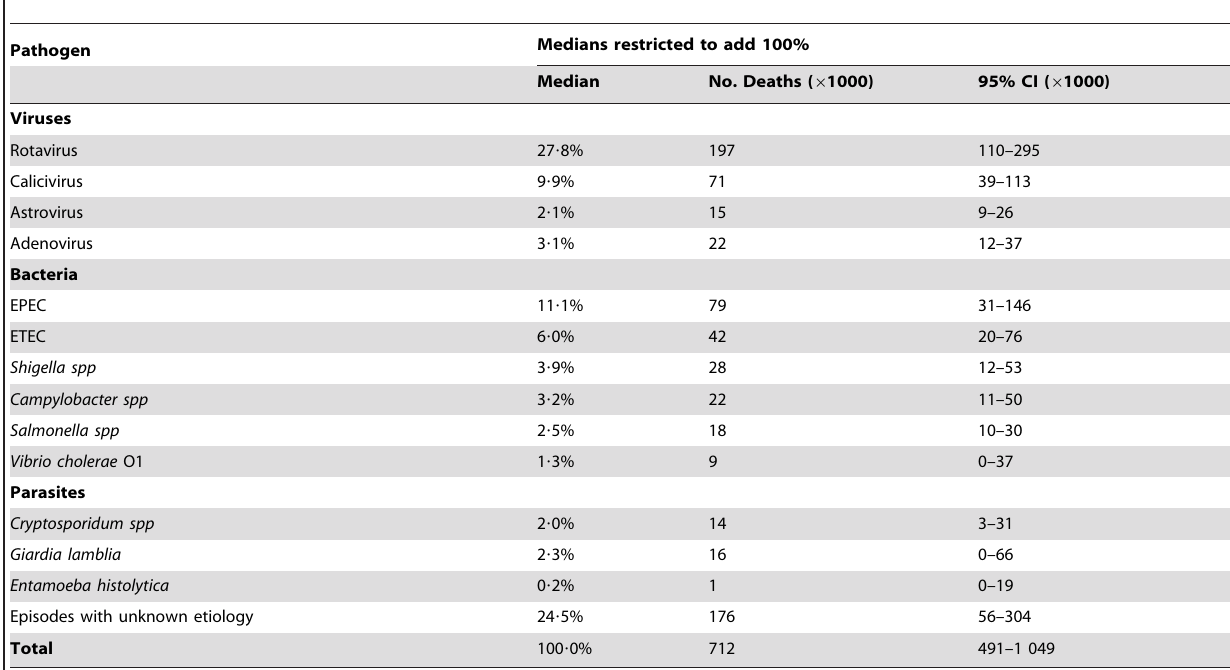
Table 3. Number of diarrheal deaths estimated for each pathogen in children 0–59 m of age in the world for the year 2011, using constrained median proportions to fit